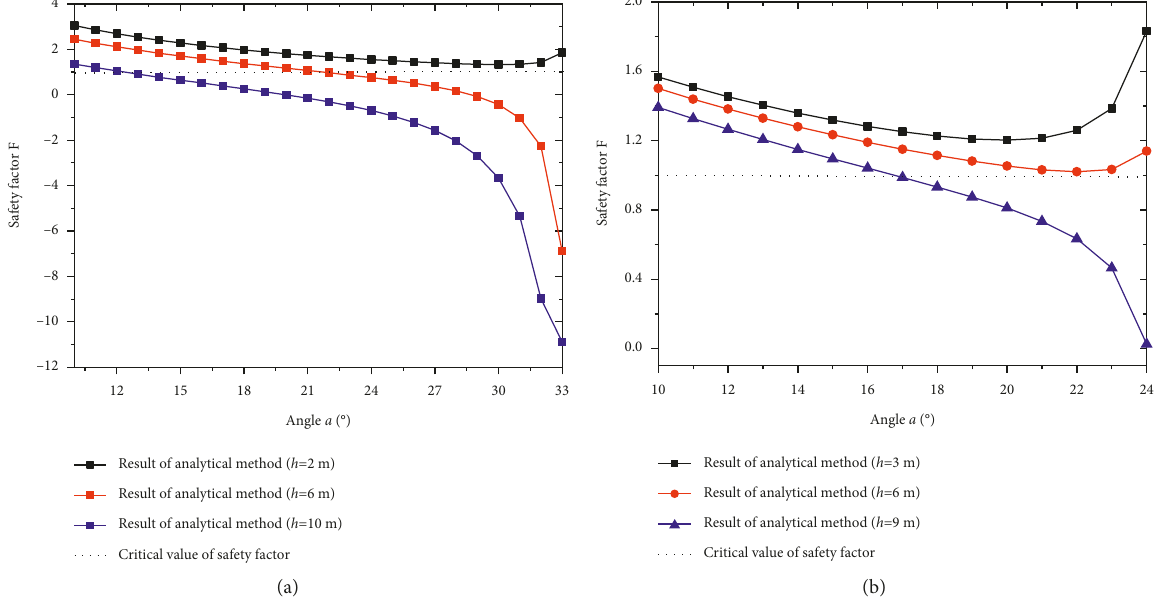
Figure 6: Relationship between safety factor F and inclination angle α . (a) Results of case 1. (b) Results of case 2.